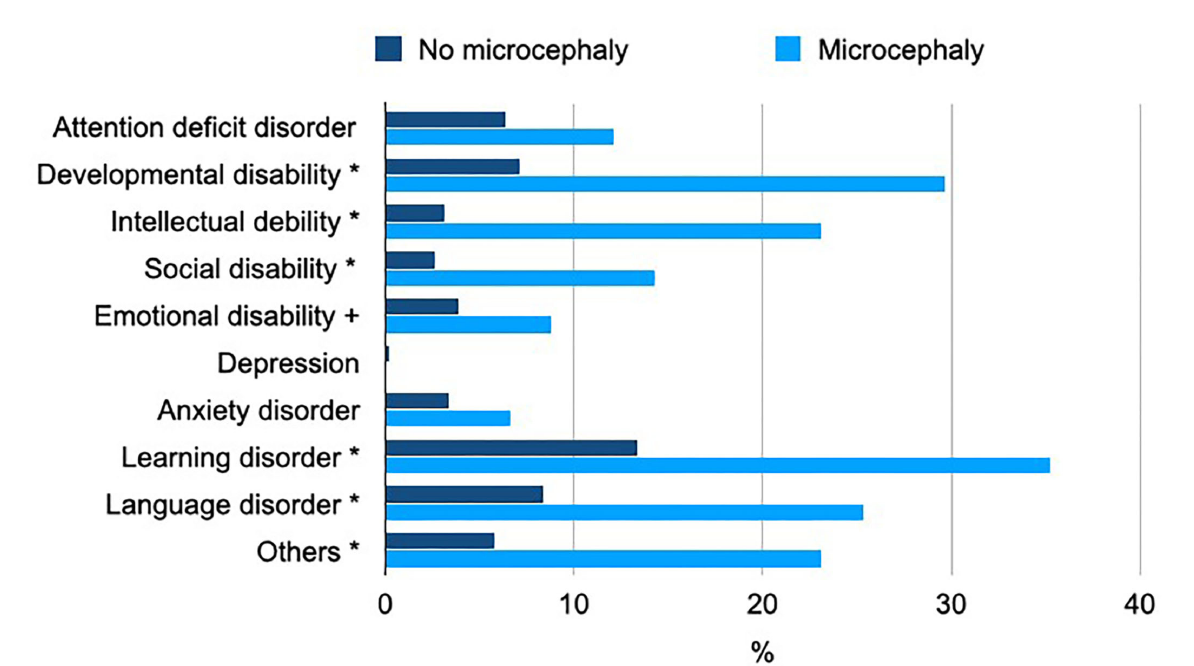
FIGURE3 Psychiatric comorbidity in microcephalic CHD patients. The chart visualizes the percentage of patients with the most prevalent psychiatric disorders among microcephalic or non-microcephalic patients; * denotes a significant difference compared to non-microcephalic, p < 0.001, and + denotes p <